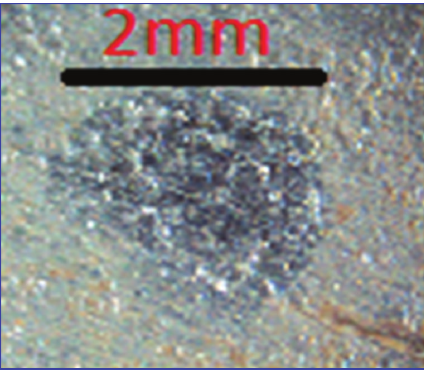
Figure 5: Variation of 𝑅 𝑎 as a function of 𝑃 𝑝 at PRR 4Hz.